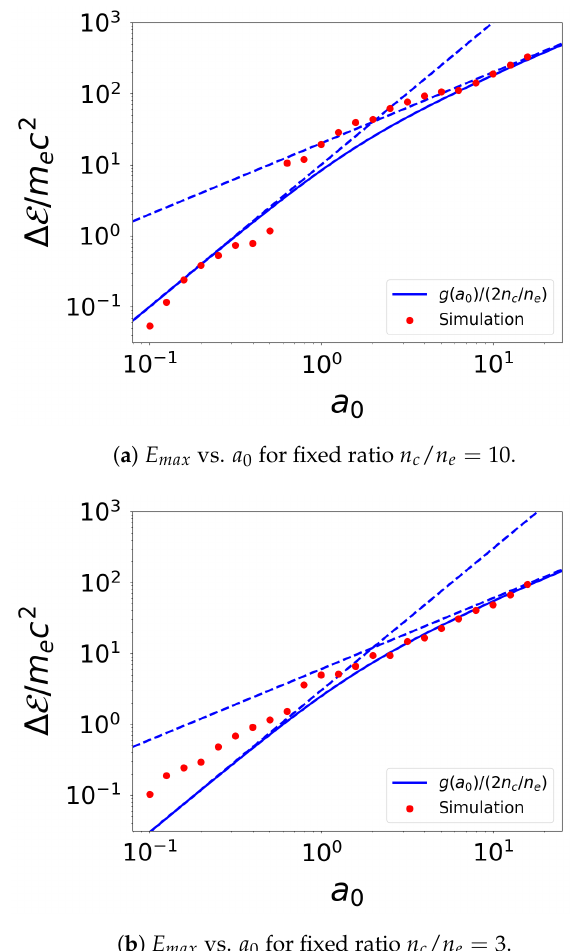
Figure 5. The maximum electron energy as a function of laser intensity a 0 for two density cases: n c / n e = 10 ( a ) and n c / n e = 3 ( b ). The maximum energies (red dots) are compared with the function g ( a 0 ) (blue solid line). The blue dashed lines represent the asymptotic behavior of g ( a 0 ) for a 0 (cid:28) 1 and a 0 (cid:29)